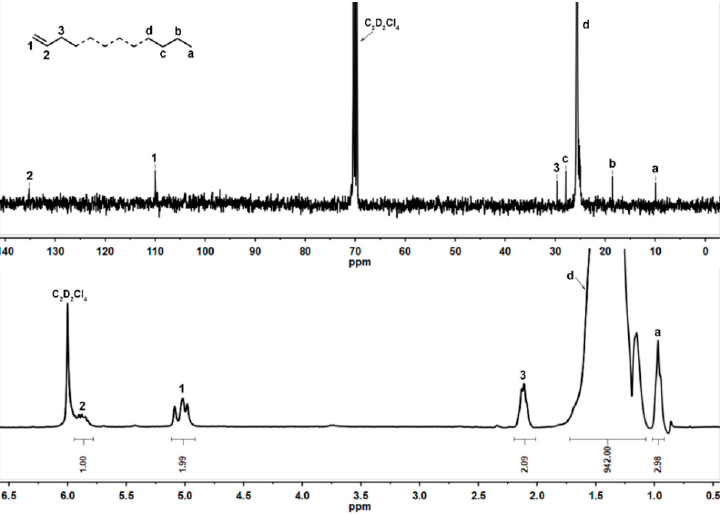
Figure 2. The NMR spectrum of the polyethylenes obtained by Co2 /MMAO at 70 °C (run 19, Table 2).